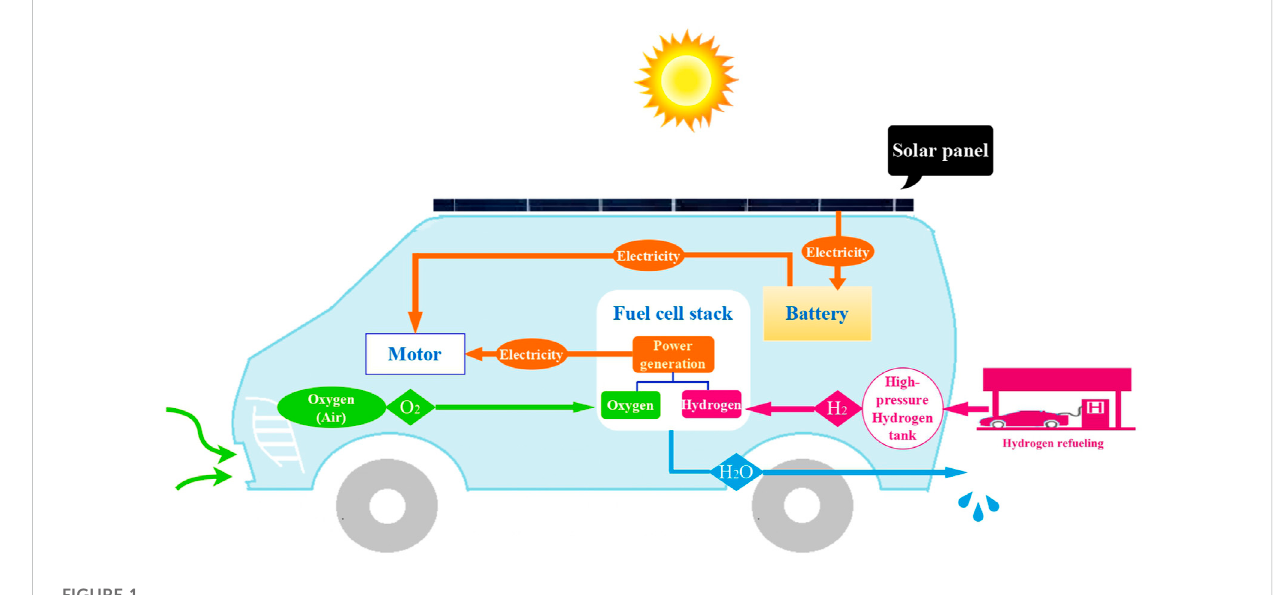
FIGURE 1 Energy fl ow diagram of hybrid source-fed EV.